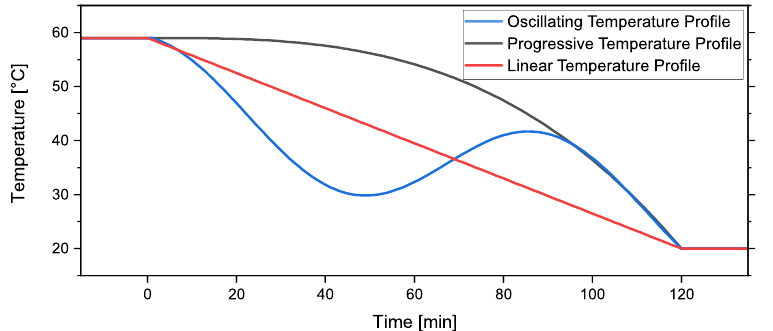
Figure 6. Temperature profiles investigated in this work. The linear temperature profile T l ( t ) , progressive temperature profile T p ( t ) , and oscillating temperature profile T o ( t )